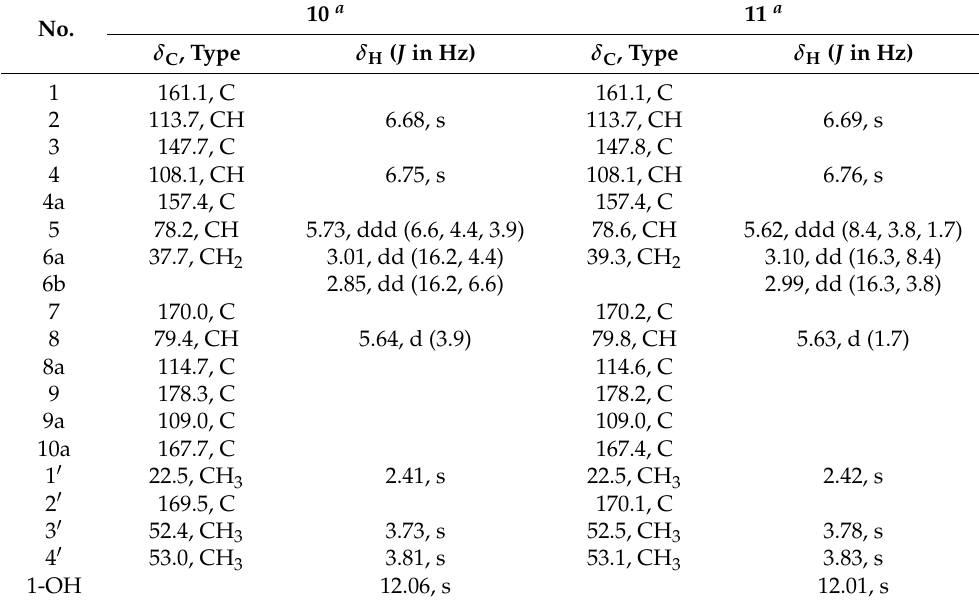
Table 4. 1 H (600 MHz) and 13 C (150 MHz) NMR Spectroscopic Data for 10 and 11